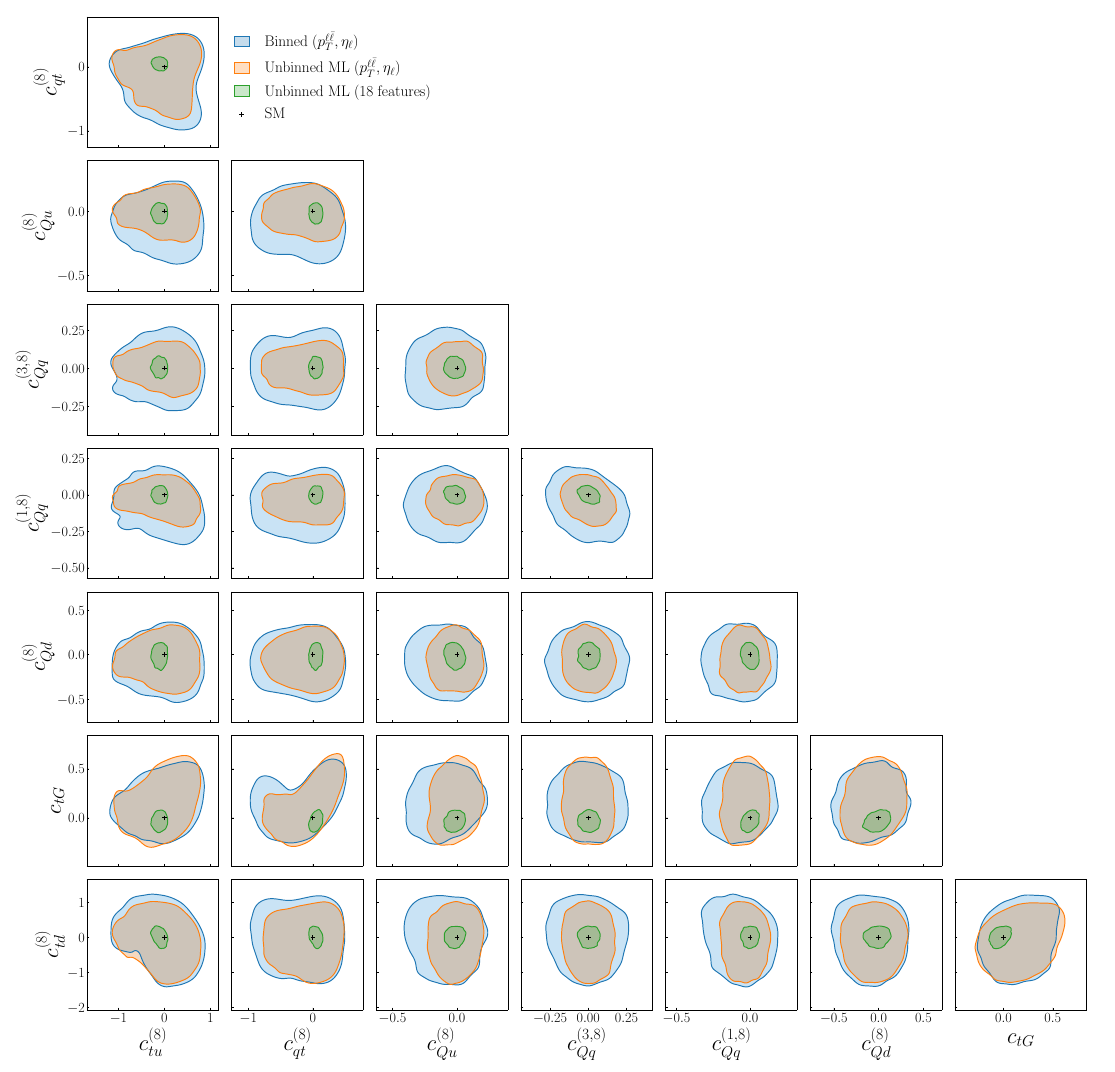
Figure 14. Same as figure 13 comparing the bounds obtained from the binned and unbinned observables built upon two kinematic features, p ‘ ¯ ‘ and η ‘ , with the corresponding results for the T unbinned ML observable trained on the full set of n k = 18 kinematic